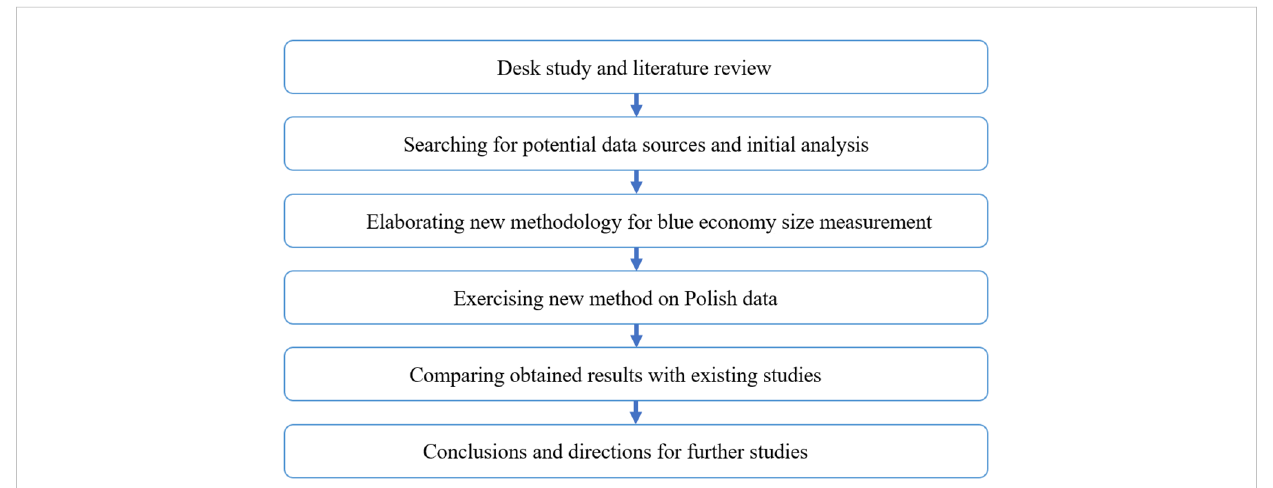
FIGURE 1 Stages of conducted research. Source: own